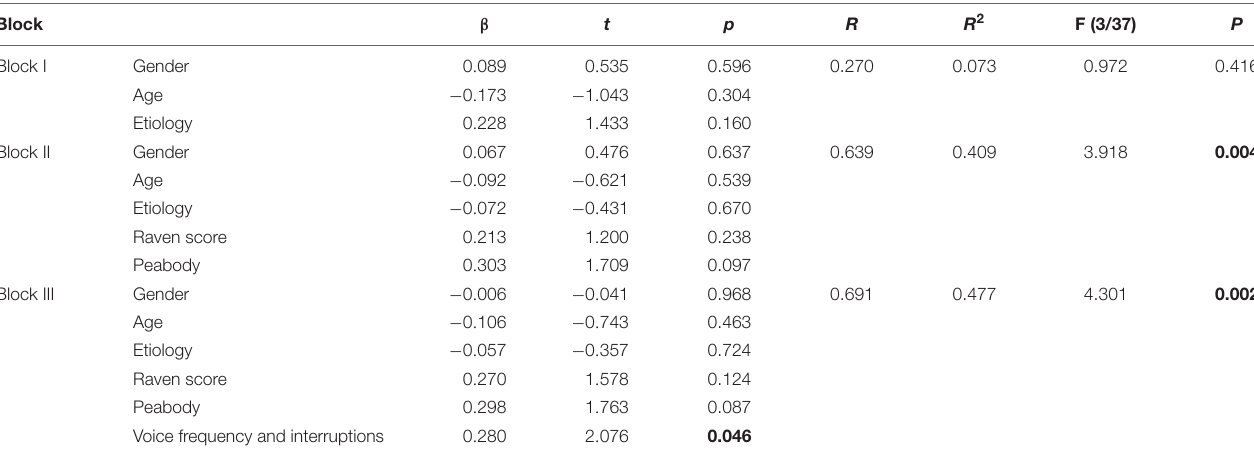
TABLE 5 | Results of hierarchical regression analysis for predicting paralinguistic production of emotions. Block